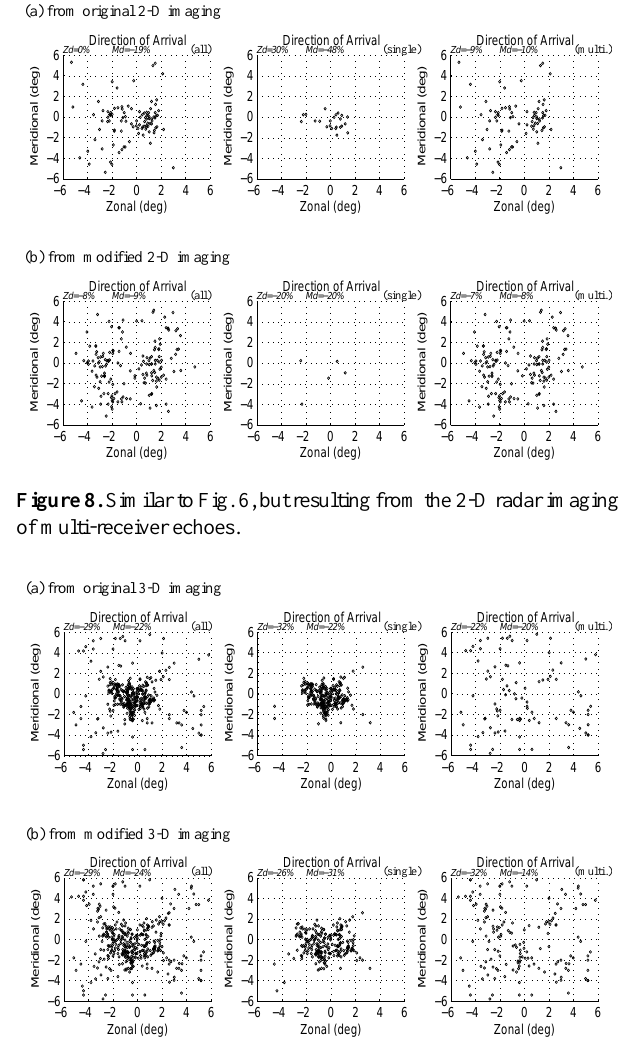
Figure 9. Similar to Figure 6, but obtained from the echoes in the sampling gate between 4.8 km and 4.95 km.